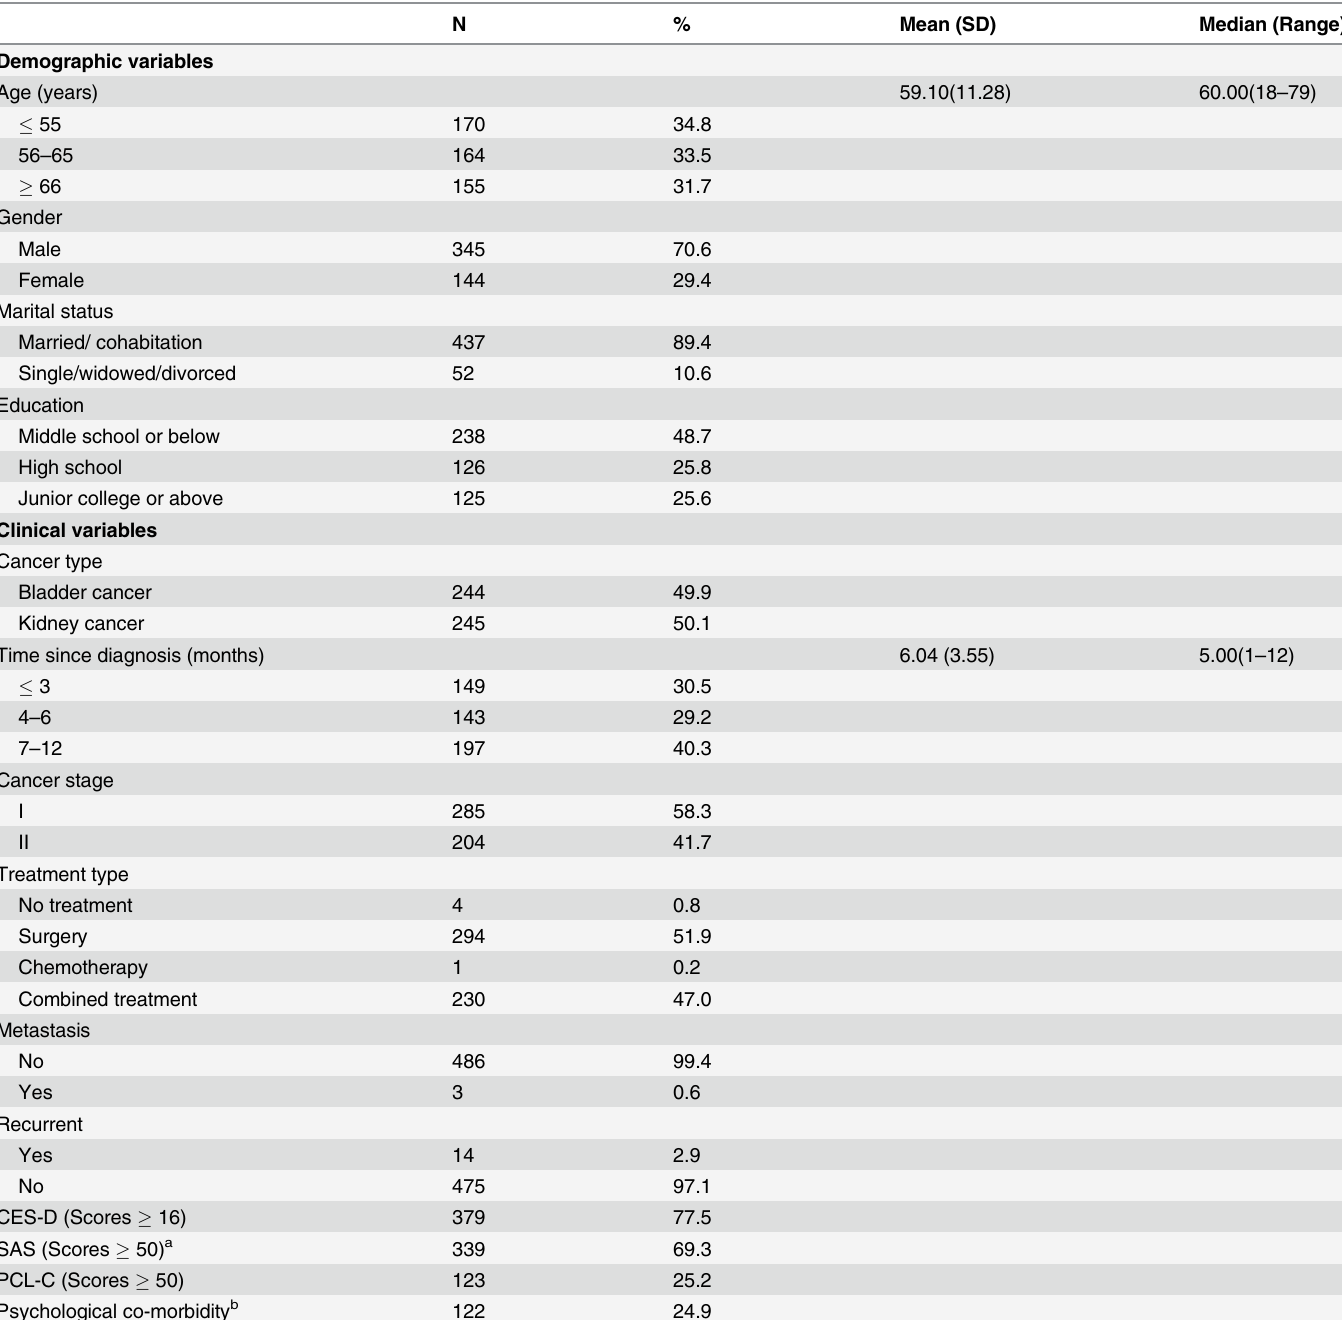
Table 1. Patient Characteristics (N =